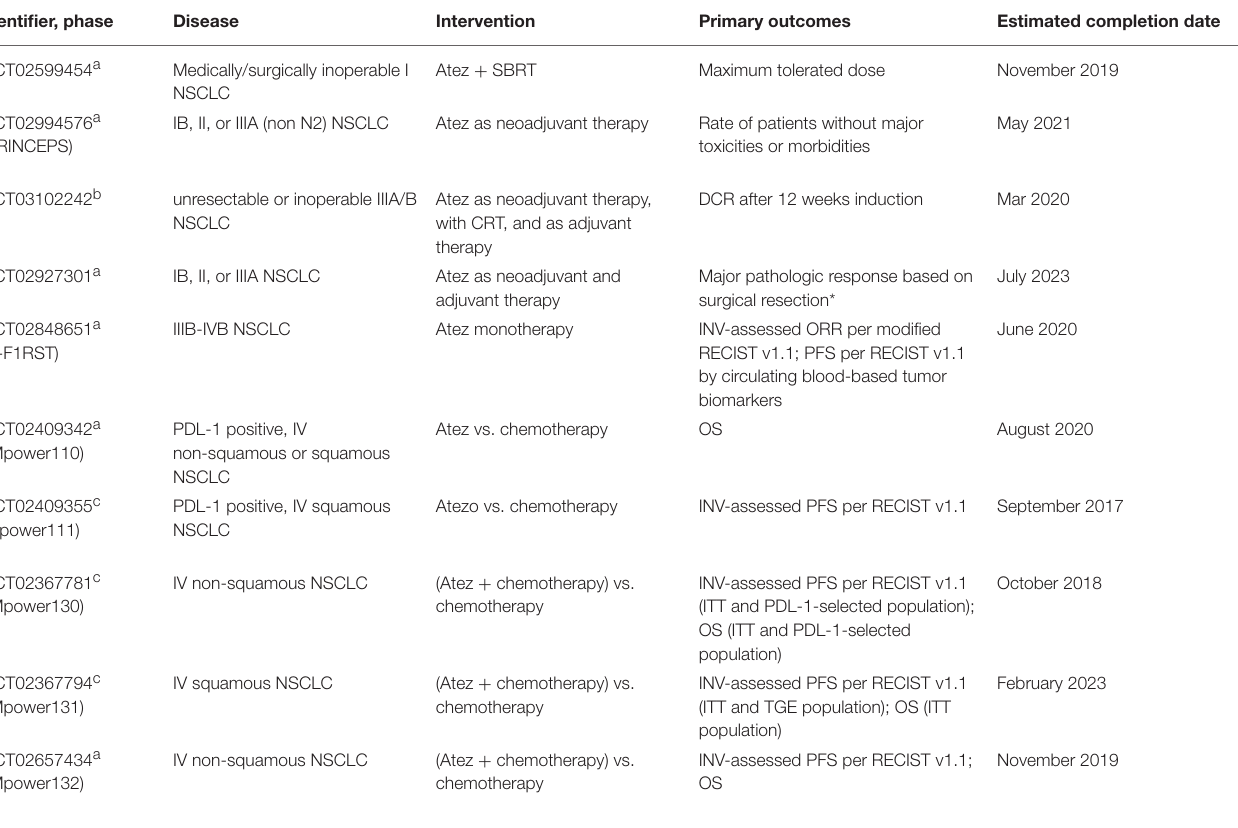
TABLE 2 | Current trials without